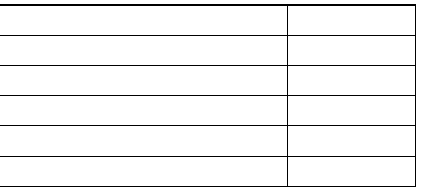
Table: 3 Indications of dialysis